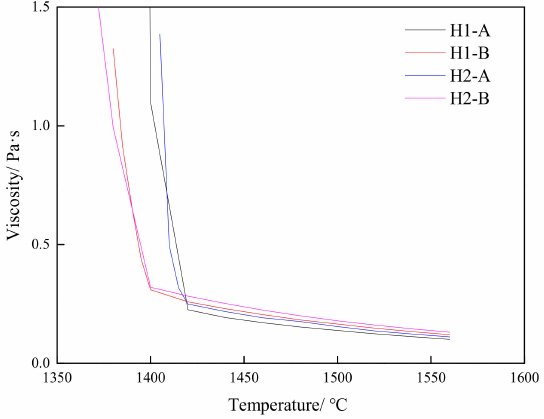
Figure 11. The viscosity curves of different